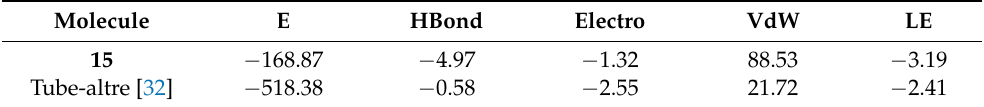
Table 2. Principal interaction energies between the studied ligands and the KLK5 protein. E means the total interaction energy, HBond is the hydrogen bond interactions, Elstat is the electrostatic interaction, VdW represents the Van der Waals interactions and LE is the Ligand Efficiency (LE = E/#heavy atoms), all in kcal/mol.